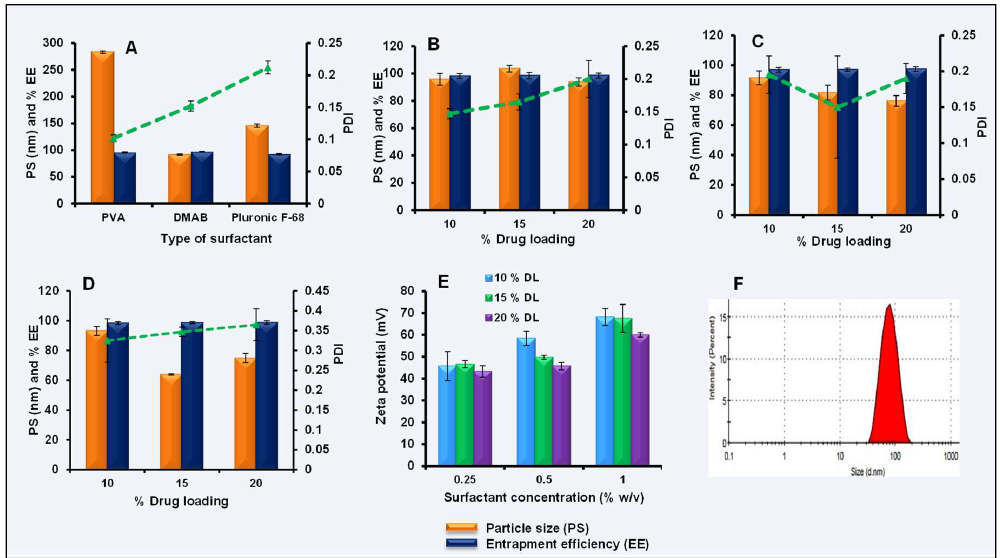
Figure 2. Preparation and optimization of CBZ nanoparticles (NPs): ( A ) Effect of type of surfactant on particle size, PDI, and entrapment efficiency of CBZ NPs, ( B ) effect of 0.25% w/v didodecyltrimethylammonium bromide (DMAB) concentration on particle size, PDI, and entrapment efficiency of CBZ NPs, ( C ) effect of 0.5% w/v DMAB concentration on particle size, PDI, and entrapment efficiency of CBZ NPs, ( D ) effect of 1% w/v DMAB concentration on particle size, PDI,